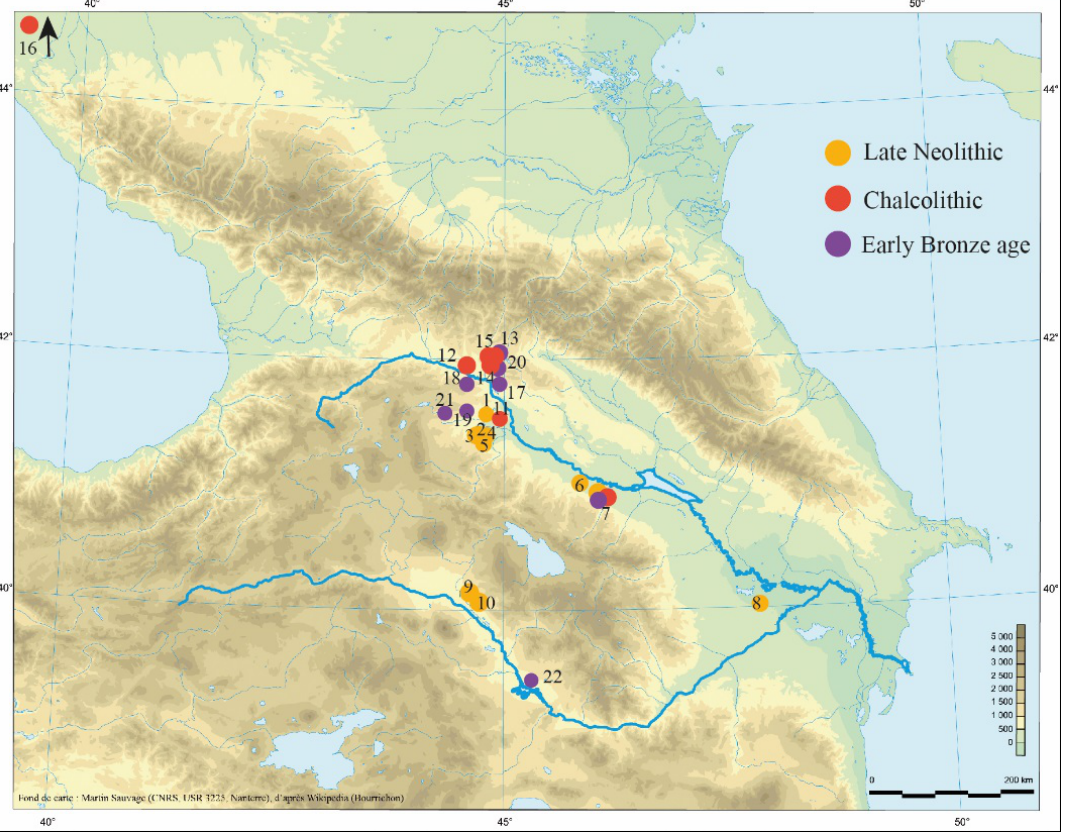
Figure 2. Localization map of the main sites mentioned in this study. Neolithic - Georgia : 1. Aruchlo, 2. Shulaveris gora, 3. Imiris gora, 4.Gadachrili gora, 5. Chramis Didi gora - Azerbaijan : 6. Goy Tepe, 7. Mentesh Tepe, 8. Kamil Tepe and Mil plain sites 4 & 5 - Armenia : 9. Aratashen, 10. Akhnashen. Chalcolithic - Georgia: 11. Sioni, 12. Bereekldebi, 13. Abasnorevi, 14. Chinti, 15. Zhinvali, Russia : 16. Majkop. Early Bronze Age Georgia : 17, Ortchosani, 18. Kwartzrelebi, 19. Samschwilde; 20. Davati; 21. Sakdrisi; Azerbaïdjan : 22.